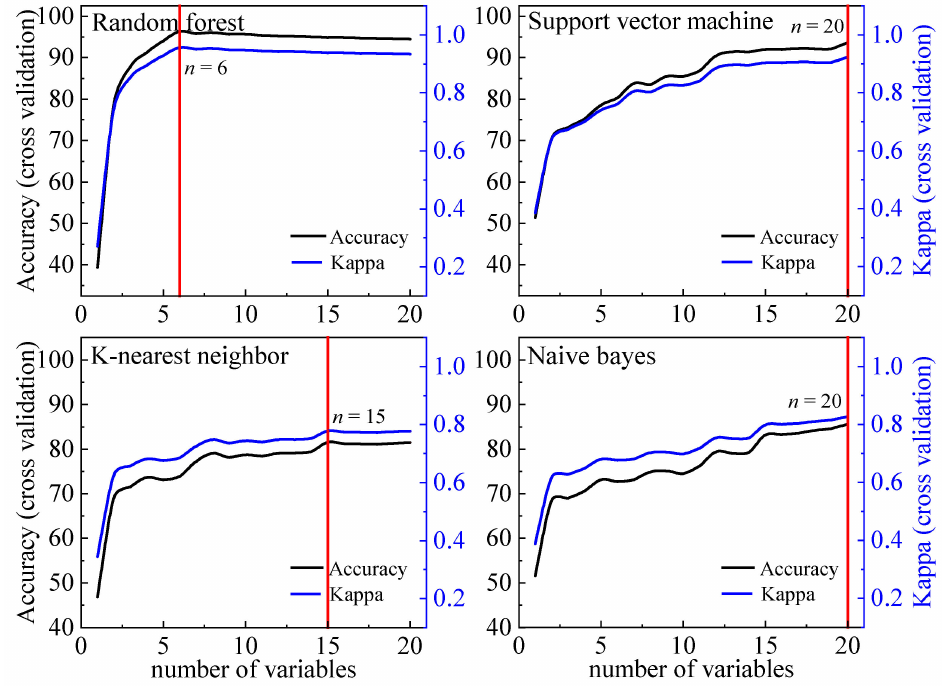
Figure 4. Relationship between the performance of pixel-based classifiers and the number of features (feature filtered by